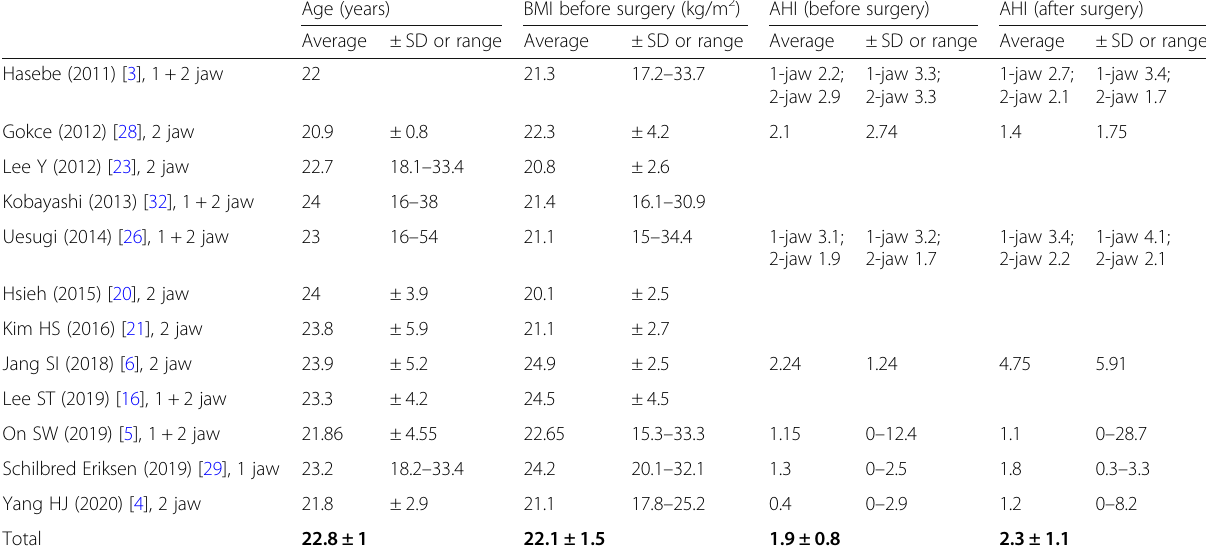
Improvement of airway patency by MMA MMA has been frequently reported to be an effective method to treat or reduce OSA severity [9, 11, 35] and has shown a high treatment success rate (> 85%) [36]. Since mandibular setback surgery is in the reverse direction of mandibular advancement, an objective comparison of pre- vious findings for the two different procedures is needed. According to a systematic review and meta-analysis based on 45 studies, the preoperative AHI (57.2 ± 25.4) was significantly decreased to 9.5 ± 10.4, and the pre-